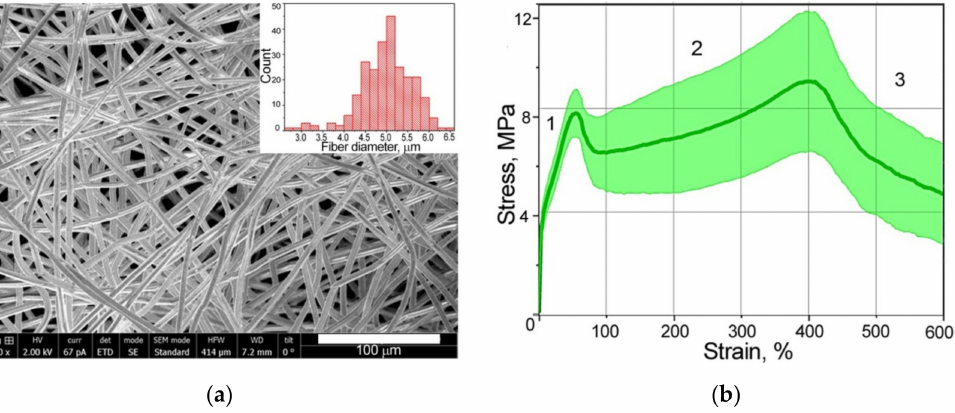
Figure 2. ( a ) SEM image of PLLA materials; ( b ) histogram of fiber diameter spread and averaged strain–stress curves of tested samples, showing statistical